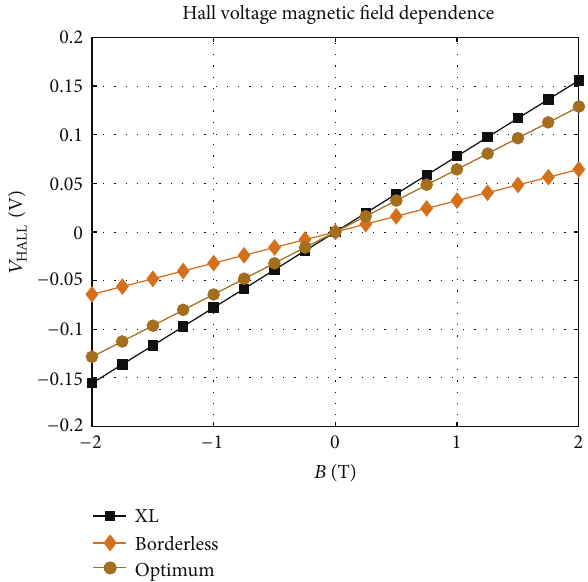
Figure 11: The simulated Hall voltage 𝑉 field strength for three integrated Hall cells.